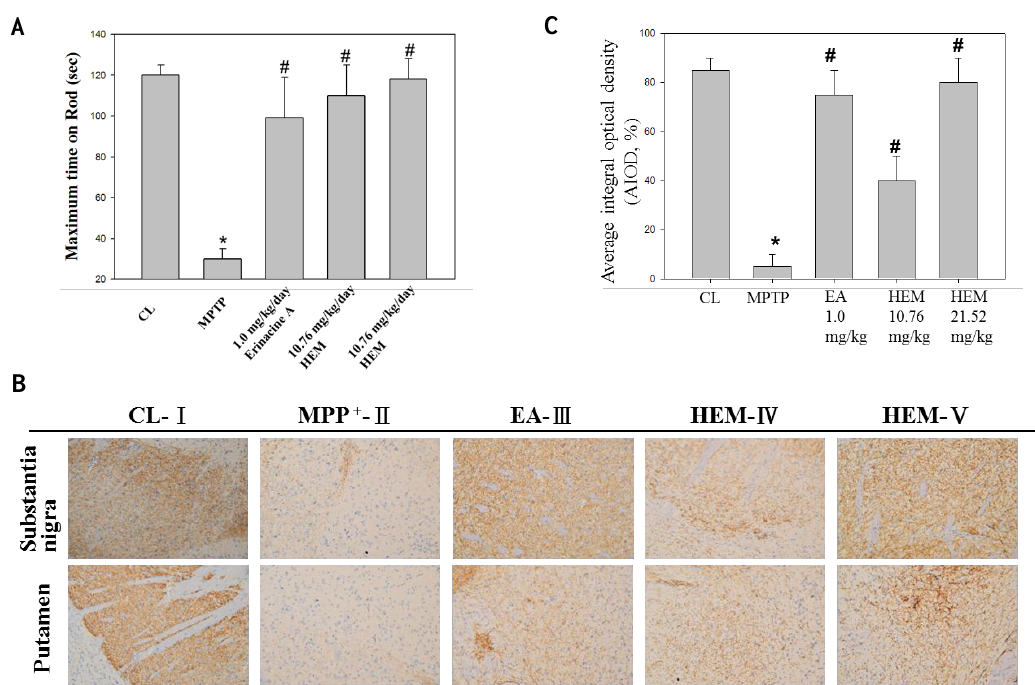
Figure 6. Post-treatment with erinacine A weakened the MPTP-induced neurotoxin and movement deficit. ( A ) Erinacine A intraperitoneally postadministered in the MPTP-treated animals after 5 days. An animal behavior test was performed 5 days after erinacine A was administered and then the animals were scarified by decapitation. Accelerating rotarod tests for the animals with MPP + or MPP + and erinacine A were performed as indicated after 1 day of training. Quantified data for the elapsed time during the six test trials is shown. ( B ) Immunohistochemistry (IHC) staining for the global IHC intensity of all dopaminergic neurons’ protein tyrosine hydroxylase in the substantia nigra of the animals. ( C ) Quantitative immunohistochemical protein tyrosine hydroxylase was evaluated according to the average integrated optical density (AIOD). The positive stained area was evaluated from three randomly selected observation fields for each brain section. Data are expressed as mean ± S.D. (n = 6 / group); * p < 0.05, as compared to the control group, magnification × 400; * p < 0.01, as compared to the control group; # p < 0.01, as compared to the MPP + -treated group.